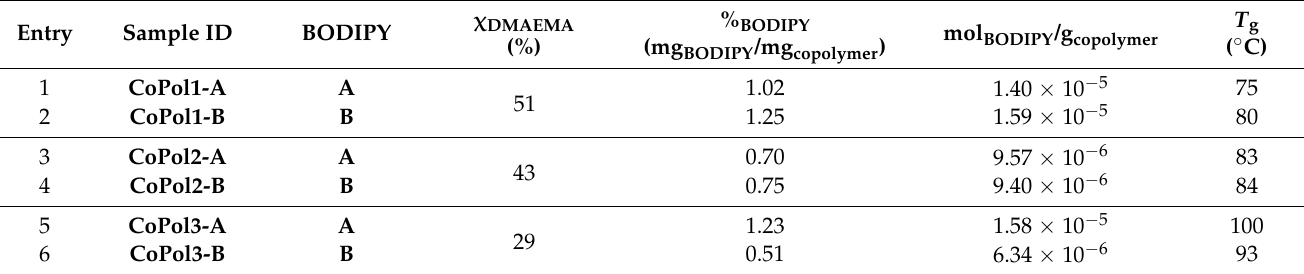
Table 2. BODIPY content in P(MMA ‐ ran ‐ DMAEMA) copolymers.